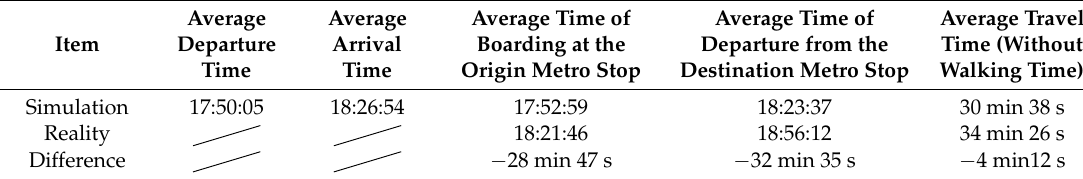
Table 5. The differences between simulation and reality when getting off work.